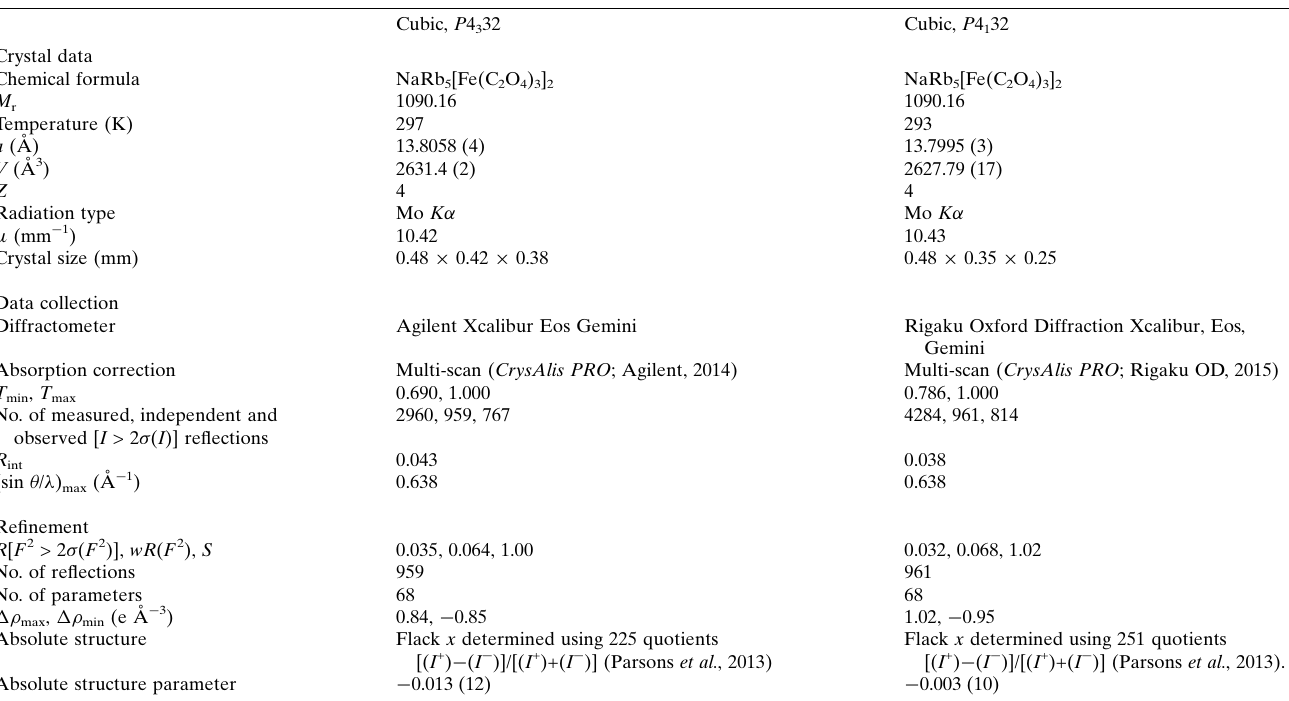
Table 3 Experimental